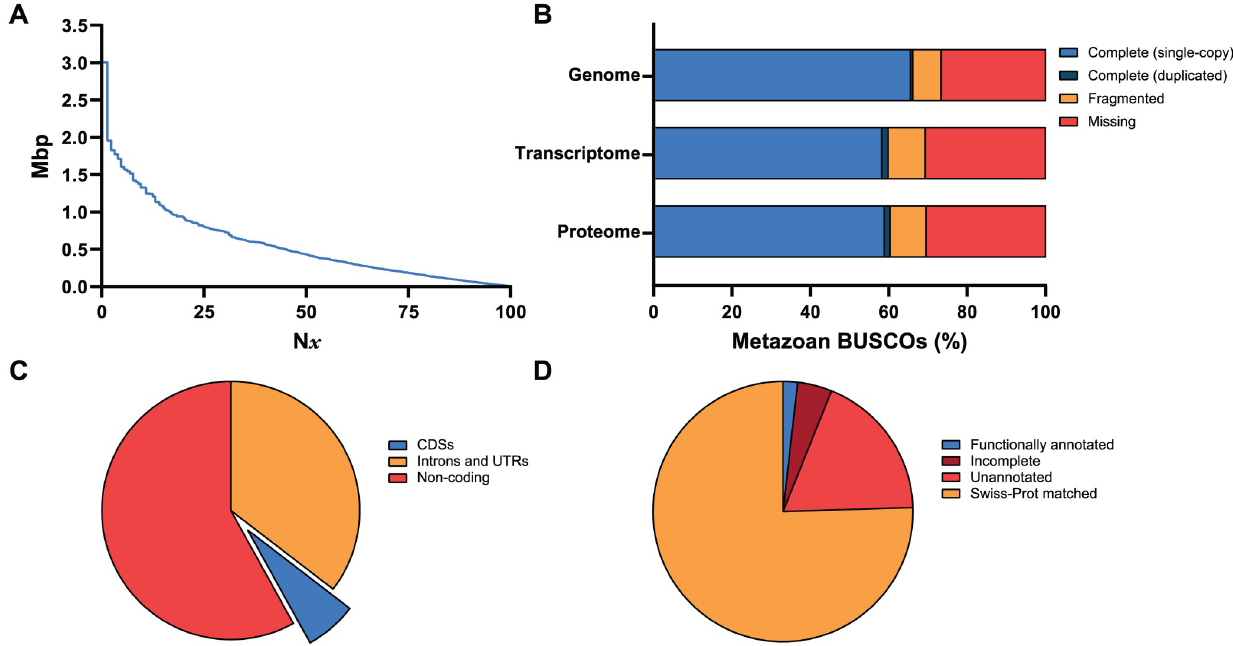
Fig 2. Contiguity, completeness, and gene prediction and annotation statistics of the Cardicola forsteri genome assemblies. (A) N x plot of the genome assembly, depicting the contig size distribution. (B) BUSCO statistics for the genome assembly, and the hypothetical transcripts and gene set (proteins), measured as a proportion of complete, fragmented, and missing BUSCOs from the metazoa_odb10 database. (C) Pie chart showing the sizes (bp) of predicted CDSs, introns, and UTRs as a proportion of the genome ( n = 216,531,548). (D) Pie chart showing the number of hypothetical polypeptides ( n = 8,564) that were functionally annotated, matched to the Swiss-Prot database or not (unannotated), and incomplete. BUSCOs, Benchmarking Universal Single-Copy Orthologs; CDS, coding sequence; UTR, untranslated region.